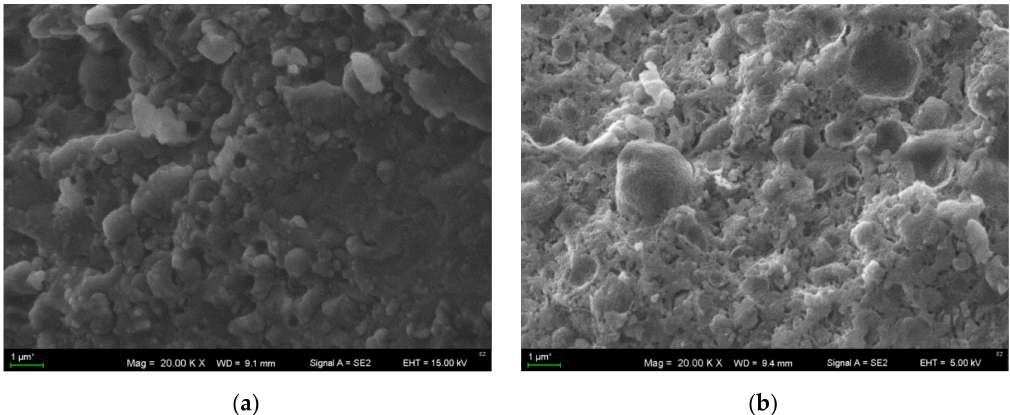
Figure 3. Scanning electron microscopy (SEM) images at magnification × 2000 of Feta-type cheese structure before ripening ( a ) and after 16 weeks of ripening ( b ).